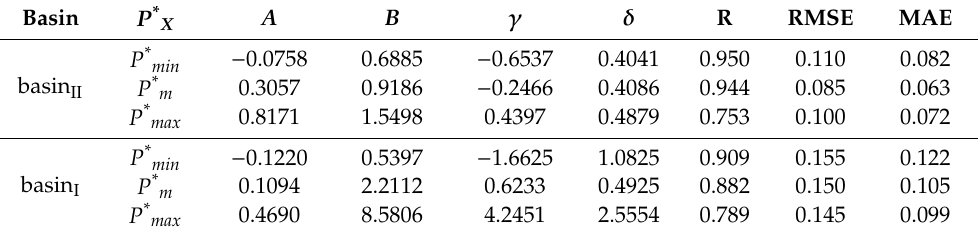
Table 2. Coe ffi cients of α , β , γ , δ , and the statistical performance criteria to estimate P * X .